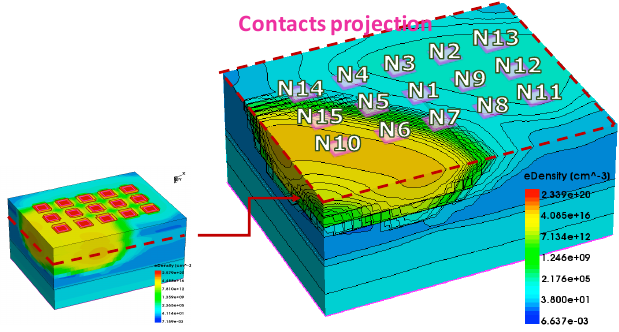
Fig. 13. Alpha generation in the 15-pixels matrix. The figure on the right is a cut at depth=0.8 µ m. The represented contacts are a projection of the fifteen top contacts.